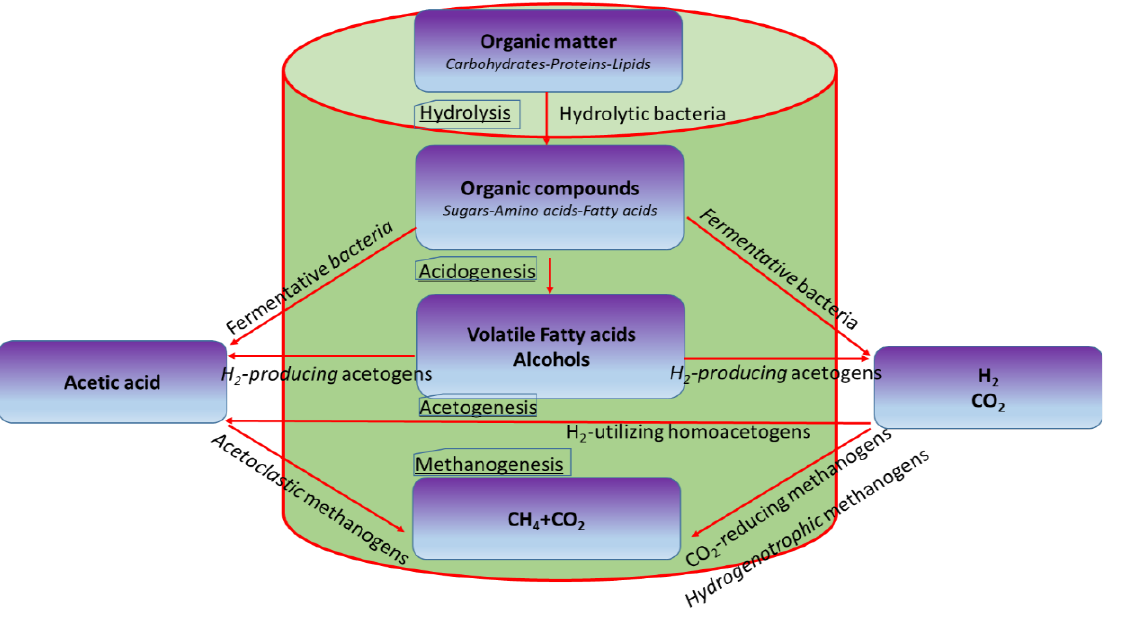
Figure 3. An overview of the major biochemical and microbiological reactions that occur throughout the anaerobic digestion process.